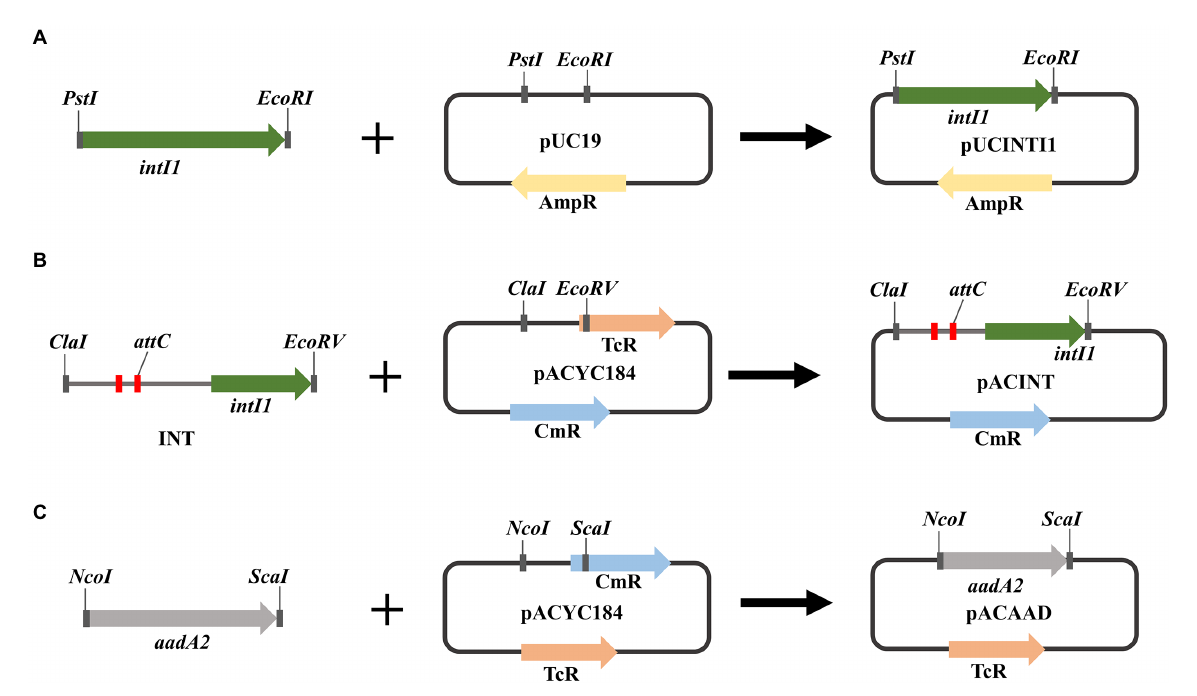
FIGURE 1 (A) Schematic diagram of recombinant plasmid pUCINTI1. (B) Schematic diagram of recombinant plasmid pACINT. (C) schematic diagram of recombinant plasmid